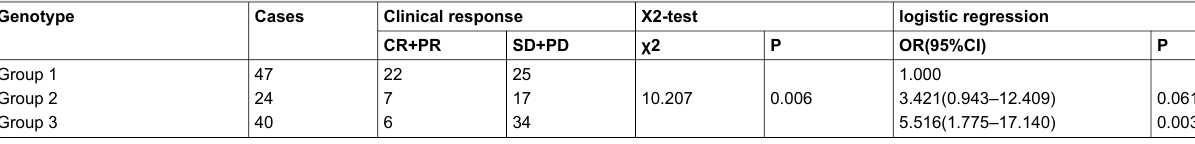
Table 4: GSTP1 and XRCC1 polymorphism and TTP (n = 105).